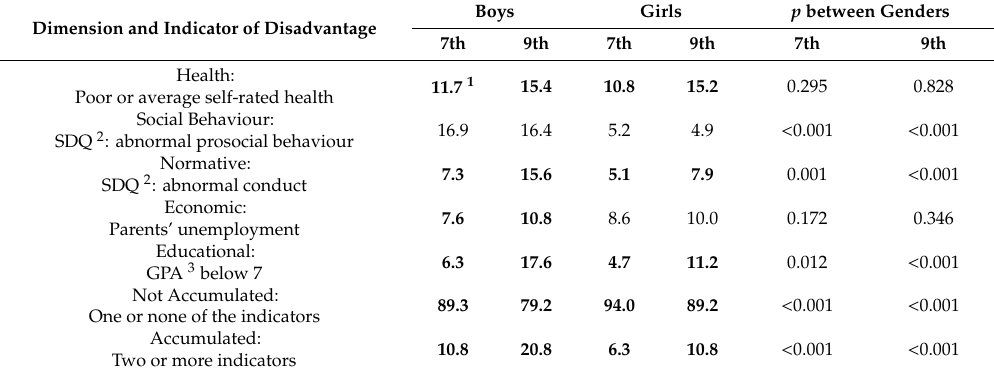
Table 2. Prevalence (%) of dimensions of disadvantage and accumulated disadvantage at the 7th and 9th grades, by gender ( N = 4337–5677) and their statistical significance ( p ) by gender and grade (95% confidence